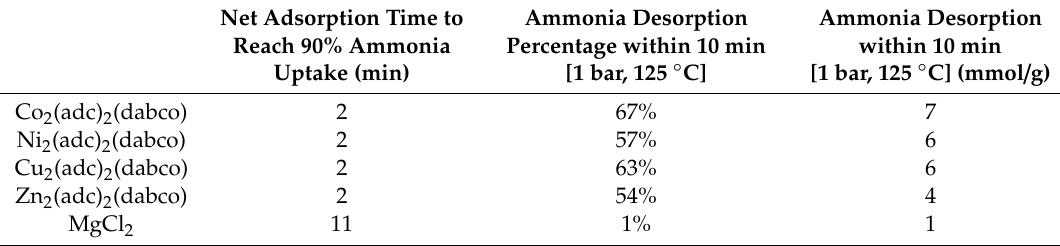
Figure 4. ( a ) Ammonia adsorption percentage in the MOFs [M 2 (adc) 2 (dabco)] (M = Co, Ni, Cu, Zn) and MgCl 2 at 25 °C, 1 bar with 100 mL/min ammonia flow after 2-min stabilization. Ammonia desorption in ammonia-saturated MOFs [M 2 (adc) 2 (dabco)] (M = Co, Ni, Cu, Zn) and MgCl 2 with 10 °C/min heat at 1 bar under 100 mL/min ammonia flow, ( b ) ammonia desorption percentage in the first 10 min from 25 °C to 125°C; ( c ) ammonia desorption capacity in the first 10 min from 25 °C to 125°C; ( d ) ammonia desorption capacity from 25 °C to 200°C. Table 2. Kinetics of ammonia adsorption and desorption of the obtained MOFs and MgCl 2.